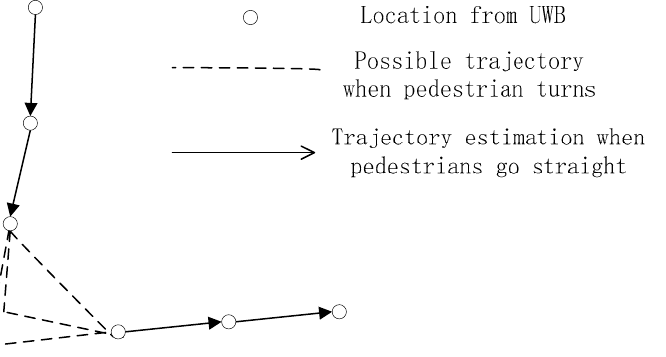
Figure 4. Trajectory estimation from Ultra-Wide Band (UWB)-based positioning results.